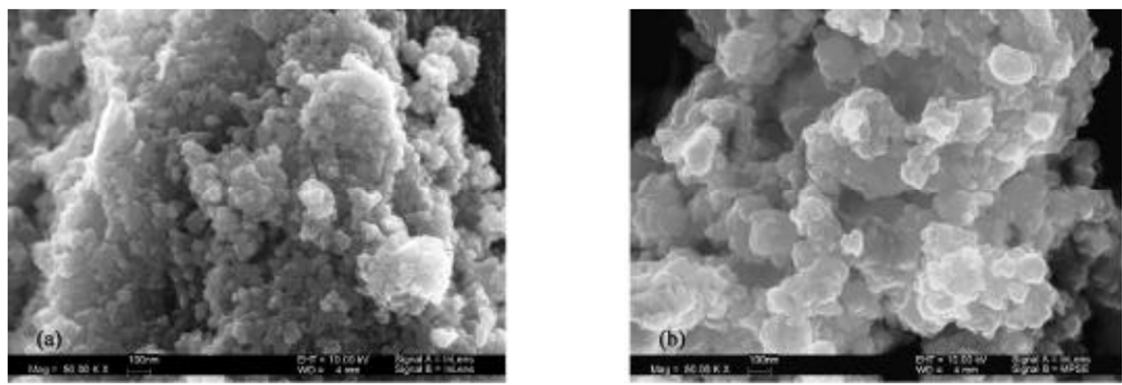
Figure 6. SEM images ( a ) before the reaction and ( b ) after the reaction. Reproduced with copyright permission from [82].